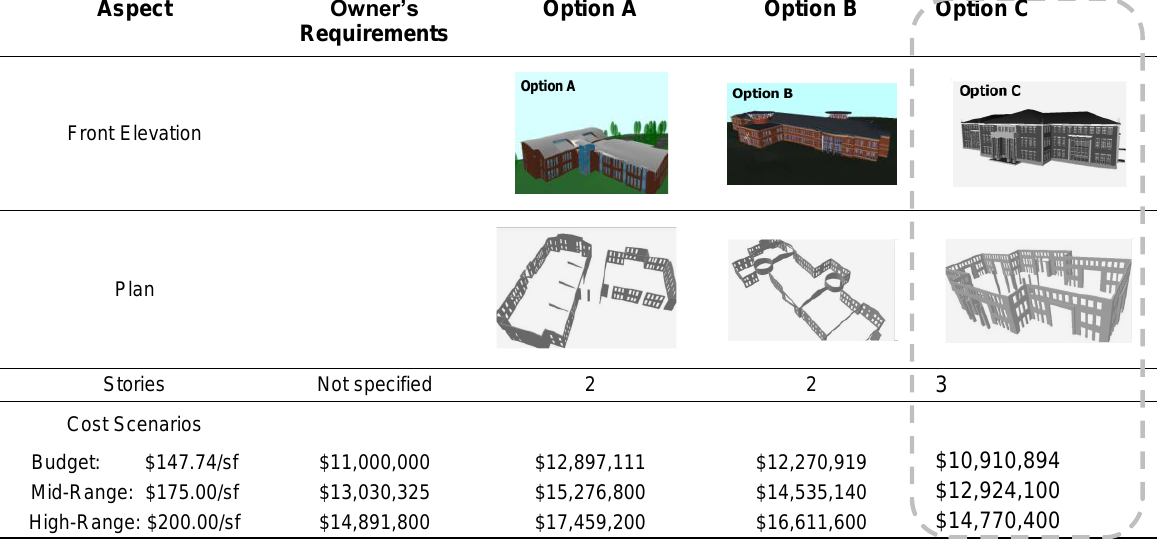
Figure 3 Options Analysis for the Savannah State Academic Building (Courtesy of: Holder Construction Company, Atlanta,